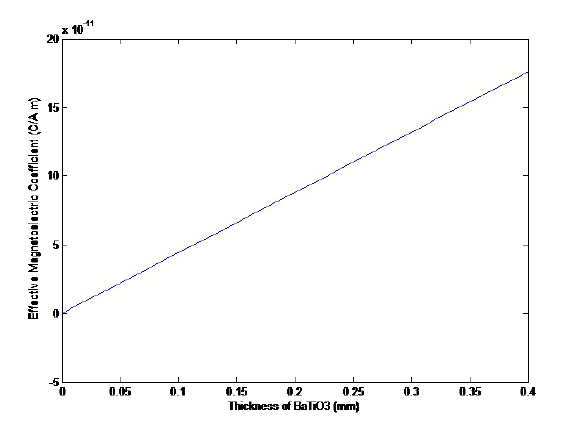
Figure 5: Plot of effective ⟨ ξ 11 ⟩ magnetoelectric coeflcient vs. thick- ness of the BaTiO 3